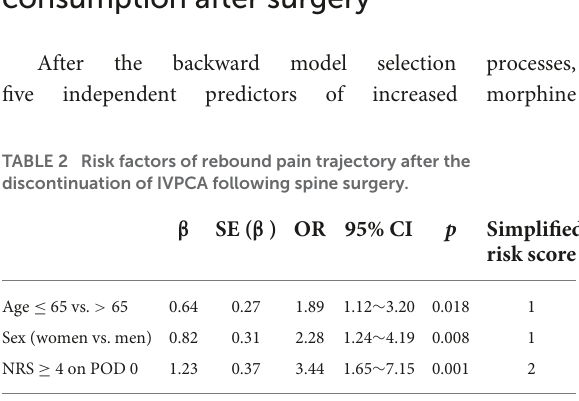
OR, odds ratio; CI, confidence interval; NRS, a numeric rating scale for pain intensity aftersurgery;POD,postoperativeday.